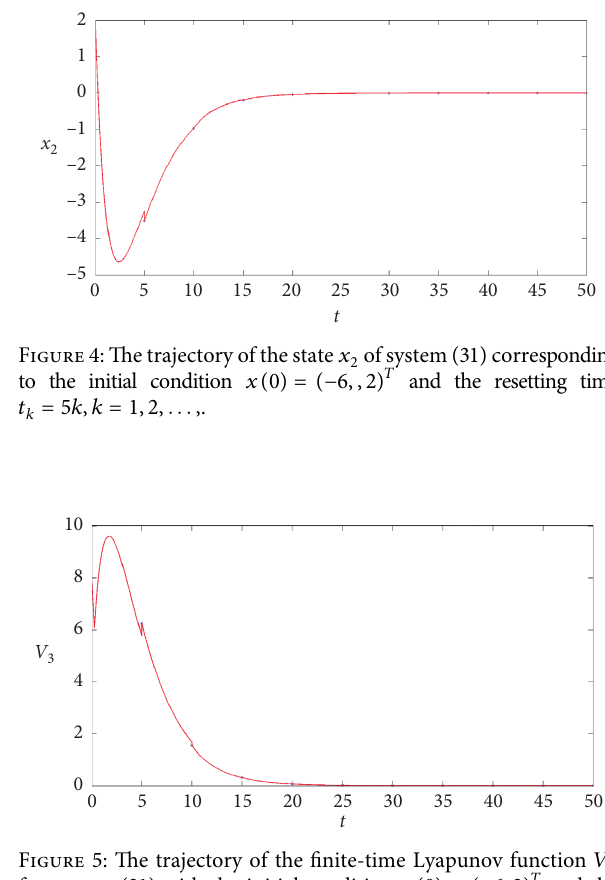
Figure 3: The trajectory of the state x sponding to the initial condition x ( 0 ) � (− 6 , , 2 ) T and the resetting time t k � 5 k,k � 1 , 2 , .. . , .